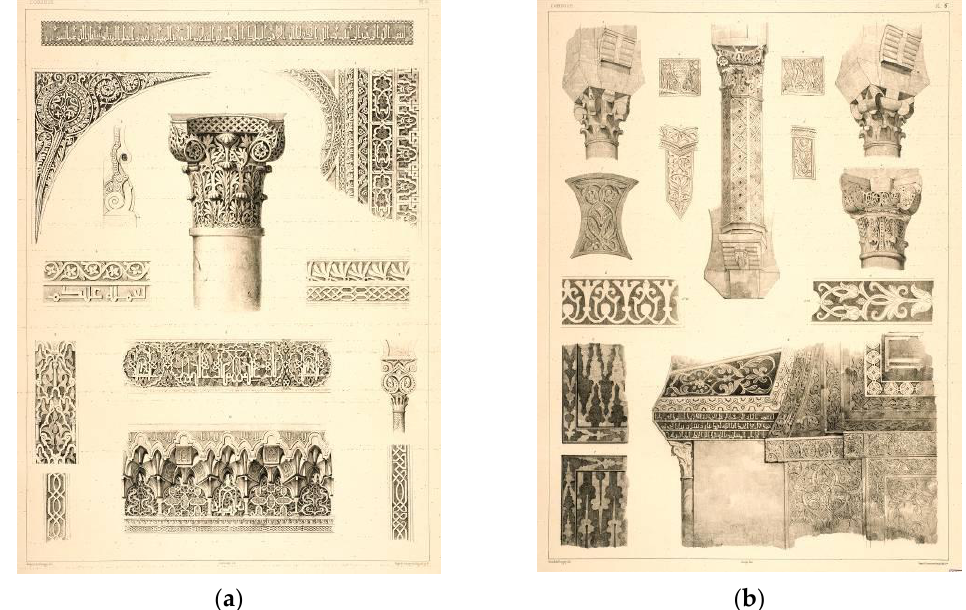
Figure 9. Girault de Prangey. ( a ) Details (Asselineau, lit.); ( b ) Details (Danjoy, lit.). Source: Monuments arabes et moresques de Cordoue, 1839.